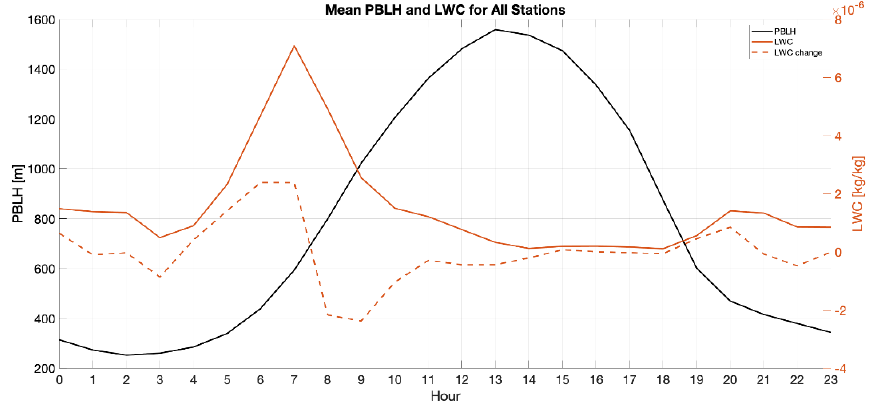
Figure 3. Mean diurnal PBLH (in black), LWC (red), and LWC change (dashed red) for June 2018. Data were analyzed for all stations based on ECMWF operational archive (LWC) and PBLH from Rea6.